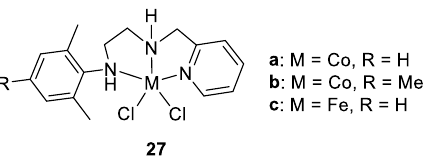
Figure 16. Aryl-substituted N -picolylethylenediamine and diethylenetriamine Co/Fe complexes. Pyrazolylpyridinamine and pyrazolylpyrroleamine ligands prepared by reducing the corresponding imine compounds were then reacted with (DME)NiBr 2 (DME: ethylene glycol dimethyl ether) to yield the nickel complexes 28 and 29 (Figure 17). When activated with aluminum cocatalysts, all four nickel complexes are active for the reaction of ethylene. The reaction products are affected by the cocatalyst and solvent. When MAO was used as the cocatalyst, ethylene polymerization in toluene produced linear high-density PE with high molecular weight. However, nickel complexes activated by EtAlCl 2 cocatalyst afforded ethylene oligomers in toluene and chlorobenzene [121].